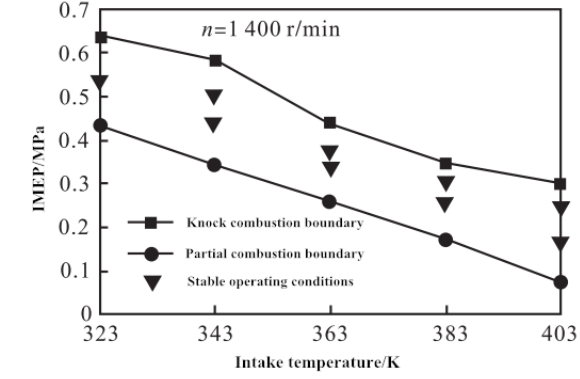
Fig. 6 Operating conditions of GCI combustion at different intake temperatures